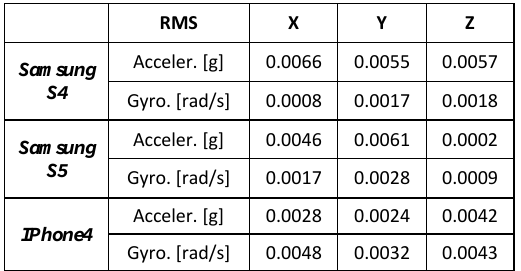
Table 3 - RMS of the inertial sensors